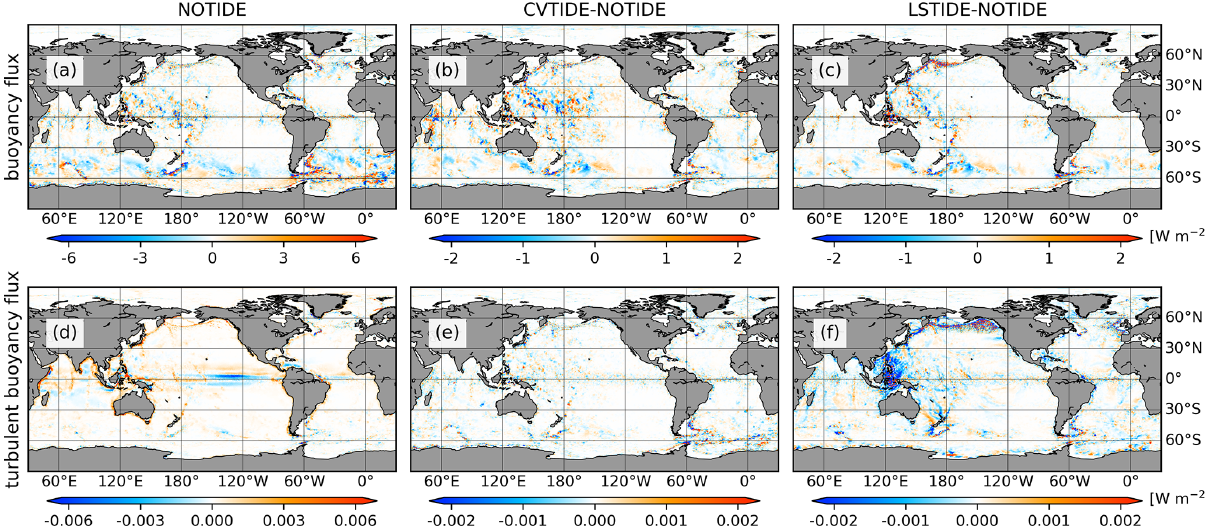
Figure 10. Horizontal distribution of vertically integrated buoyancy flux terms. Panels (a) – (c) and (d) – (f) indicate buoyancy flux and turbulent buoyancy flux, respectively. Buoyancy flux in this figure is expressed as gρw , while turbulent buoyancy flux is gρ (cid:48) w (cid:48) (positive values represent upwelling). Panels (a) and (d) show the control run, and the other panels show the